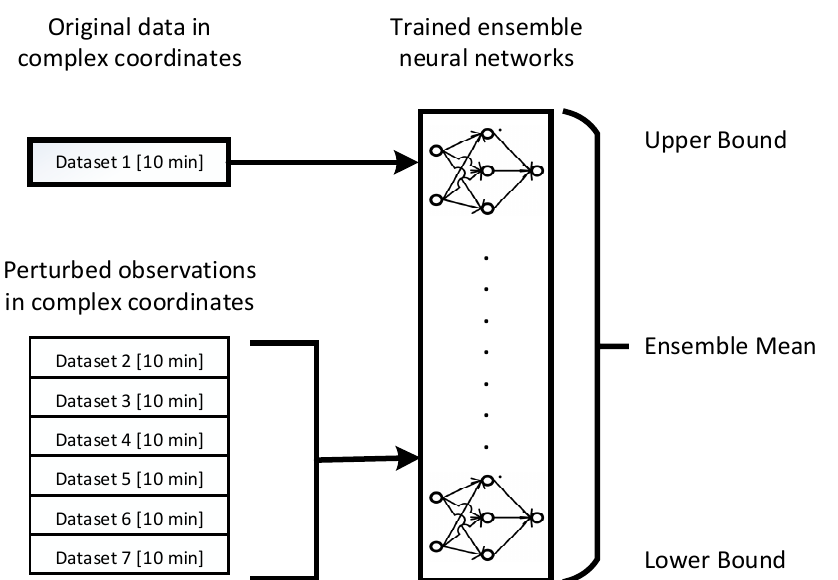
Figure 5. The Nowcasting Stage consists of seven trained ensemble neural networks capable of performing multi-step nowcasting of wind speed and direction. Nowcasting model is the same model used in previous stage of ANN training (Section 3.2). The output will be used to get the estimated wind speed and its direction (the mean value of the multiple outputs), and the probabilistic estimation for the lower and upper bounds.